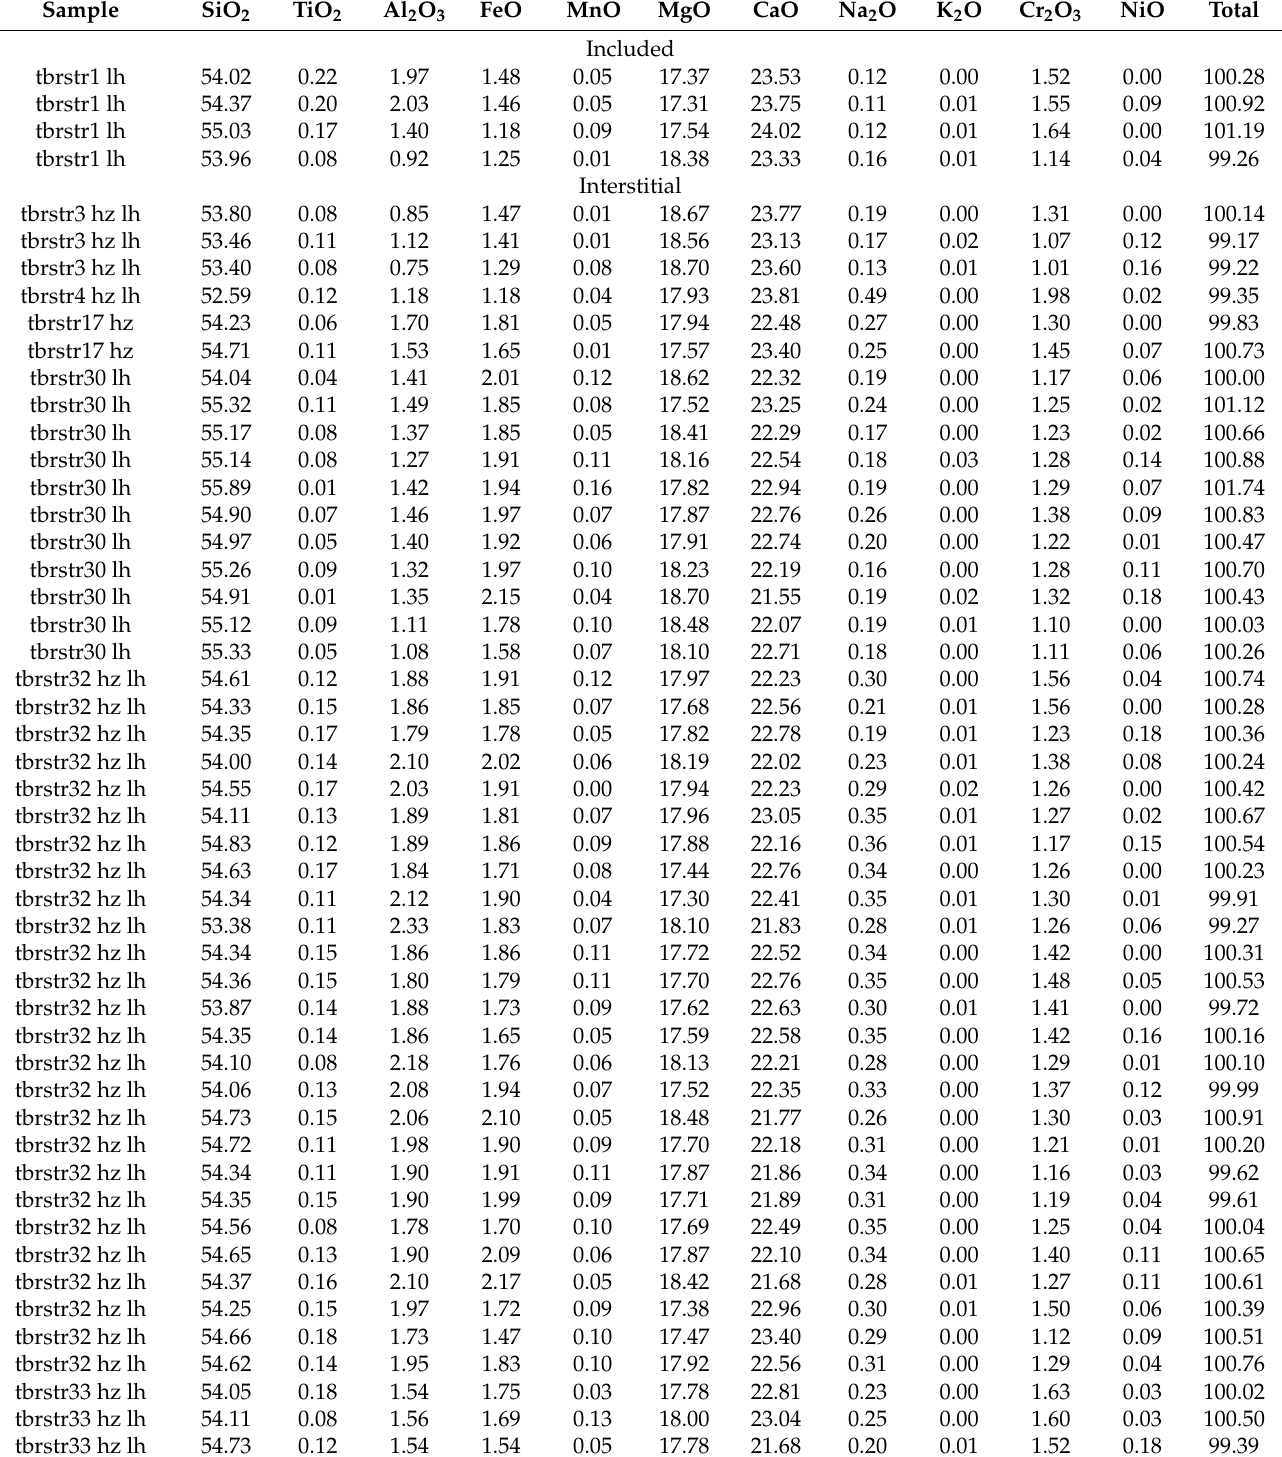
Table 3. Selected microprobe analyses of clinopyroxene (wt%) from chromitites of Kabaena Island